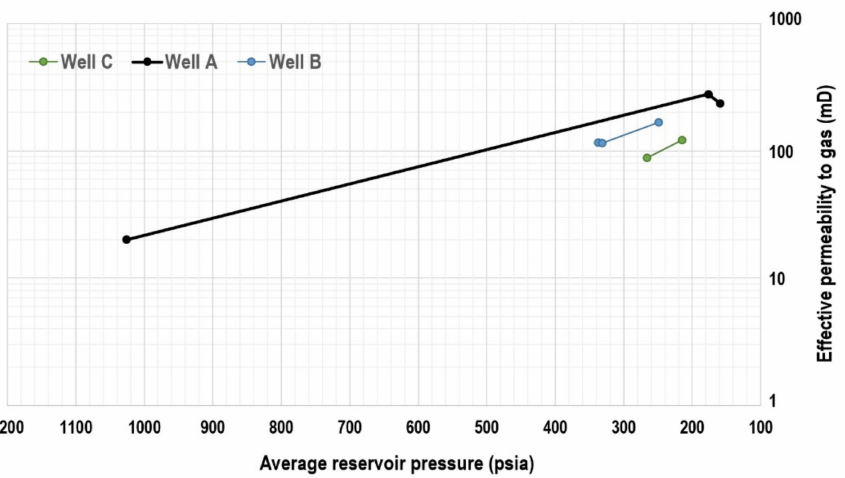
Figure 11. Change of effective permeability as a function of reservoir pressure in the Fairview field, Bowen Basin [155] (This figure was originally published in The APPEA Journal Vol 59 No 1).